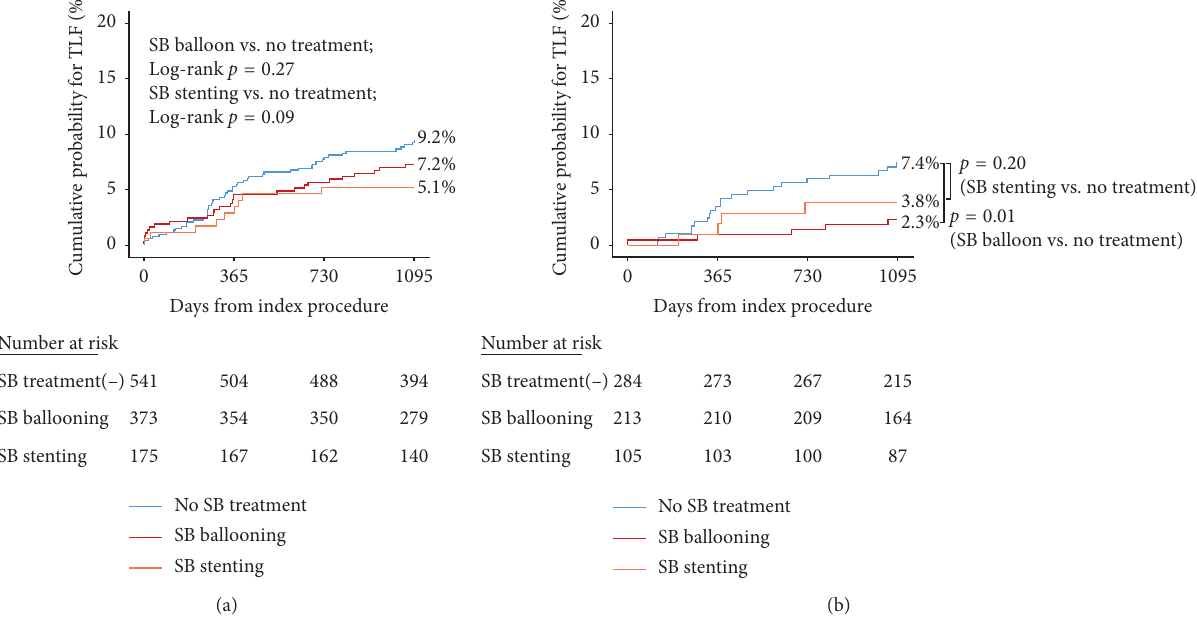
Figure 4: Kaplan–Meier curves for 3-year target lesion failure according to side-branch treatment method. (a) Whole study population. (b) ACEF-LOW group. SB, side branch. Predictors of composite outcome and post hoc